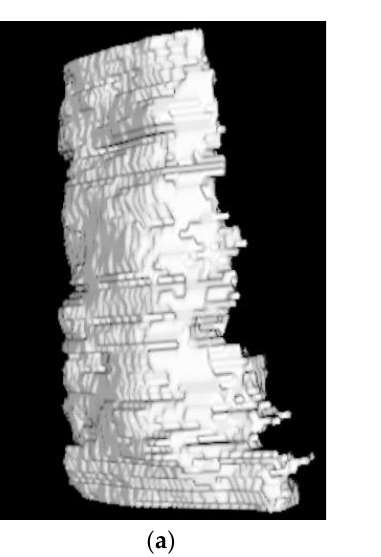
Figure 3. A three-dimensional multiplanar reconstruction of the multifidus muscle ( a ) and fat infiltration of the multifidus muscle ( b ).